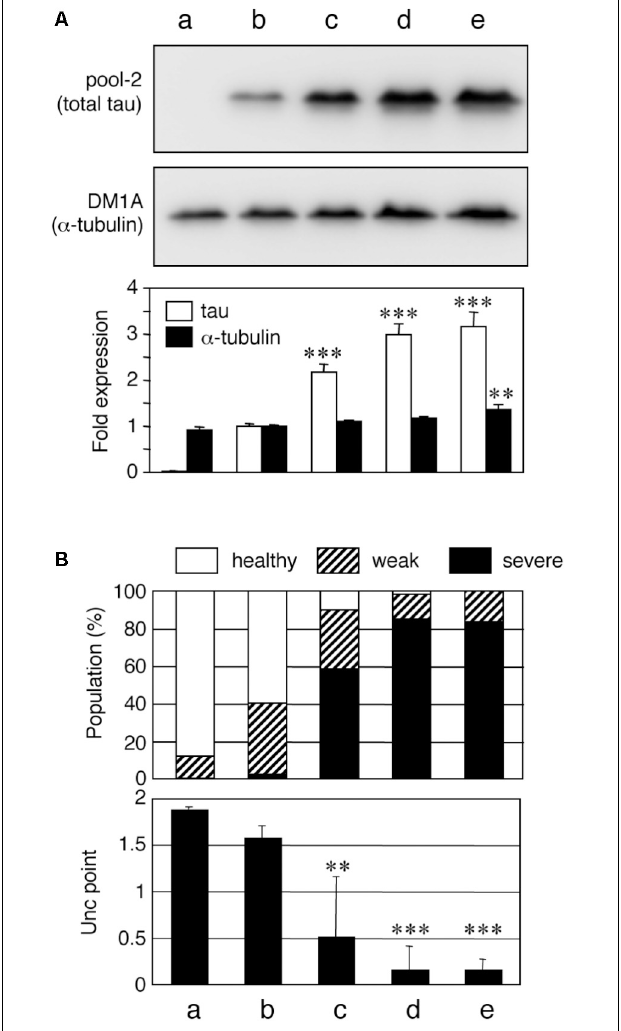
FIGURE 1 | Tau level-dependent neuronal dysfunction in WT4R-tau-Tg worms. Mock-Tg (a) , WT4R(L)-Tg (b) , WT4R(H)-Tg (c) , WT4R(ExH1)-Tg (d)